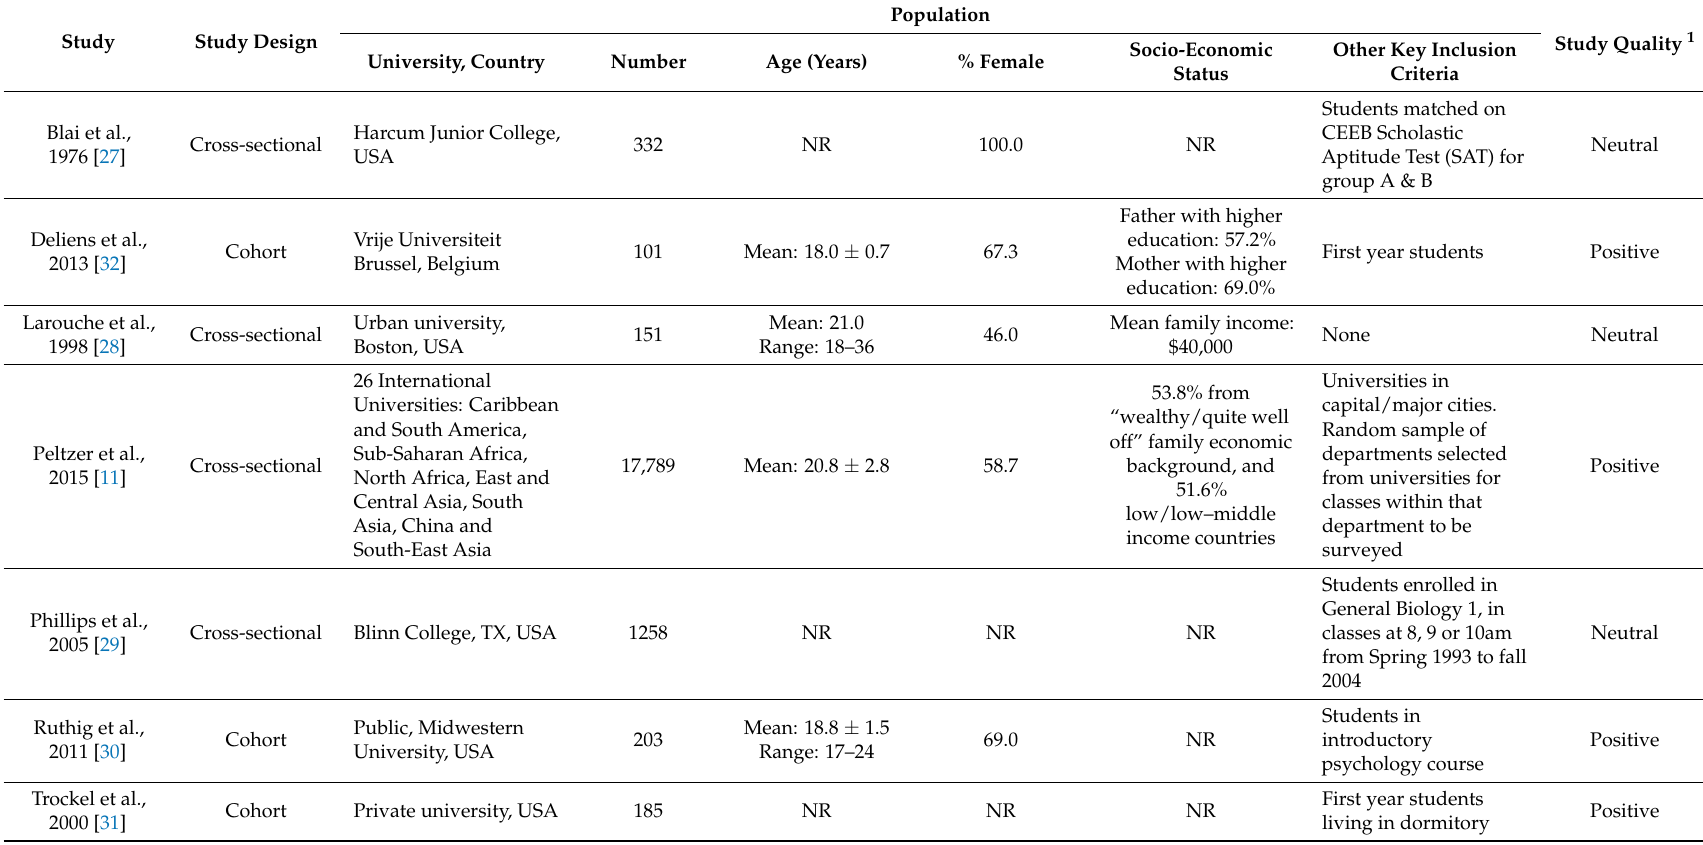
Table 1. Dietary intake and academic achievement systematic review: Study